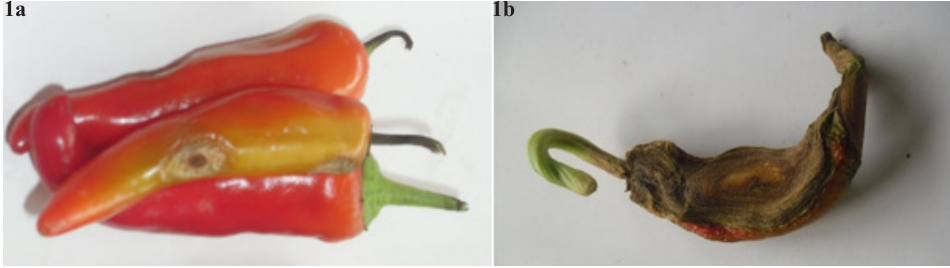
Figure 1: Anthracnose symptoms on capsicum pepper pods. 1a: C. gloeosporioides symptoms (sunken lesions on ripe fruits) on HYW; 1b: C. capsici symptoms (distorted fruit: